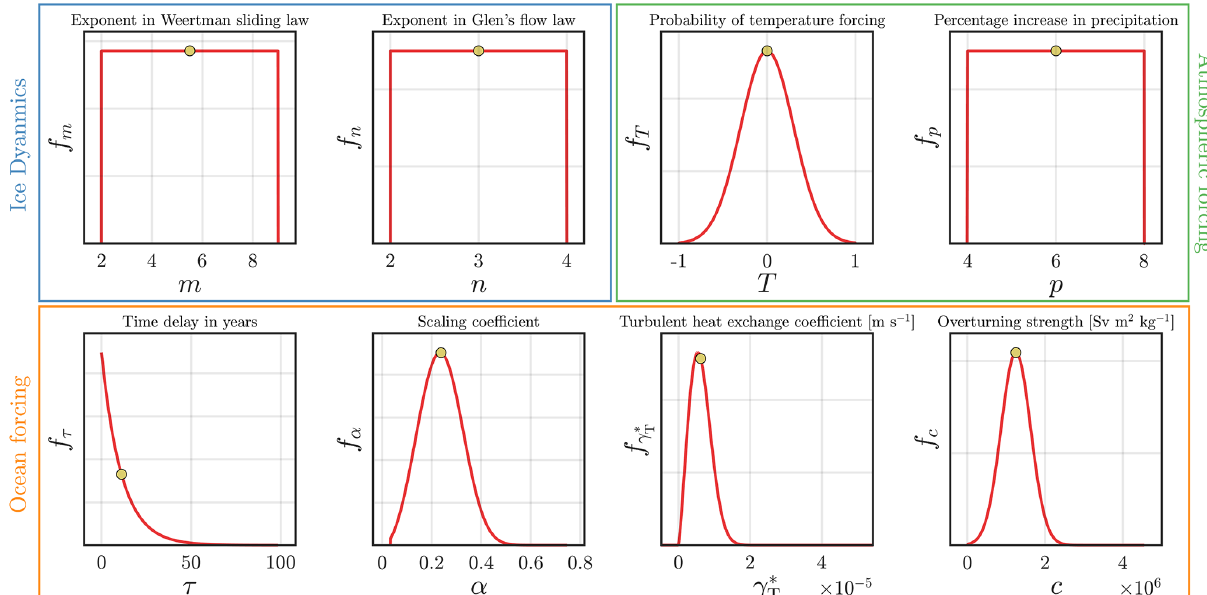
Figure 3. Probability distributions for uncertain parameters included in our analysis, grouped by ice dynamics (blue rectangle), atmospheric forcing (green rectangle), and ocean forcing (orange rectangle). For each parameter, x axes show the parameter bounds, and red lines show the probability distribution functions. Yellow circles show the sample point estimates for each of our parameters. The distributions of the four ocean forcing parameters are outputs from our Bayesian analysis (Appendix B) in which we optimized the parameter distributions using observations of melt rates beneath the Filchner–Ronne ice